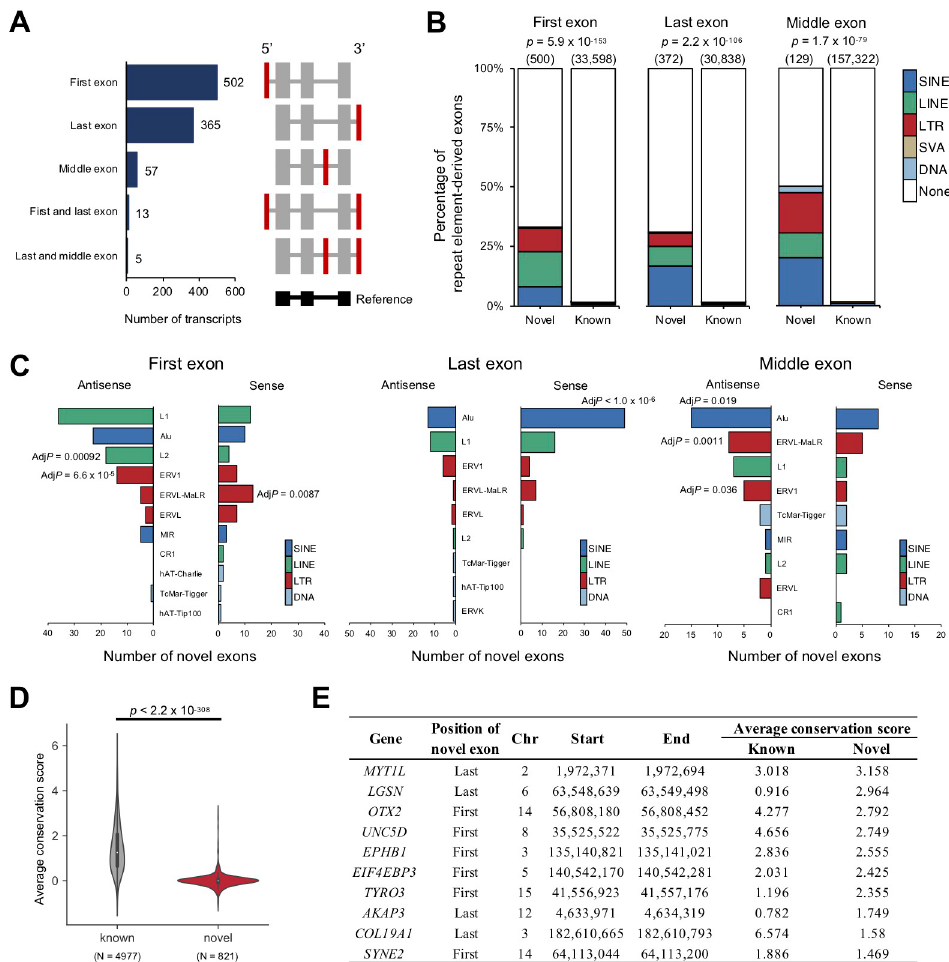
Fig 2. Features of novel exons. ( A ) Patterns of transcripts with novel exons. (Left panel) Bar graph showing the number of transcripts by the position of the novel exon. (Right panel) Schematic diagram of the location of novel exons. The novel exons are shown in red. ( B ) Percentage of TE-derived exons in novel and known exons by exon position. The stacked bar chart shows the distribution of TE-derived exons. The total number of exons is shown above the bars. Statistical significance of the total abundance of TE-derived exons between the known and novel exons was calculated by Fisher’s exact test. ( C ) The number and enrichment of TE-derived novel exons. TEs were classified by repeat family, and the sense or antisense strand for the gene strand was distinguished. The statistical significance was examined by a permutation test. P -values were adjusted by Bonferroni correction (Adj P ). ( D ) Average conservation scores between novel and known exon regions. For each gene, the average conservation scores were calculated based on the phastCons scores database (100 vertebrates). P -values were calculated by the Wilcoxon rank-sum test. ( E ) List of transcripts with novel exons with high average conservation scores. The 10 candidates are shown in order of average conservation